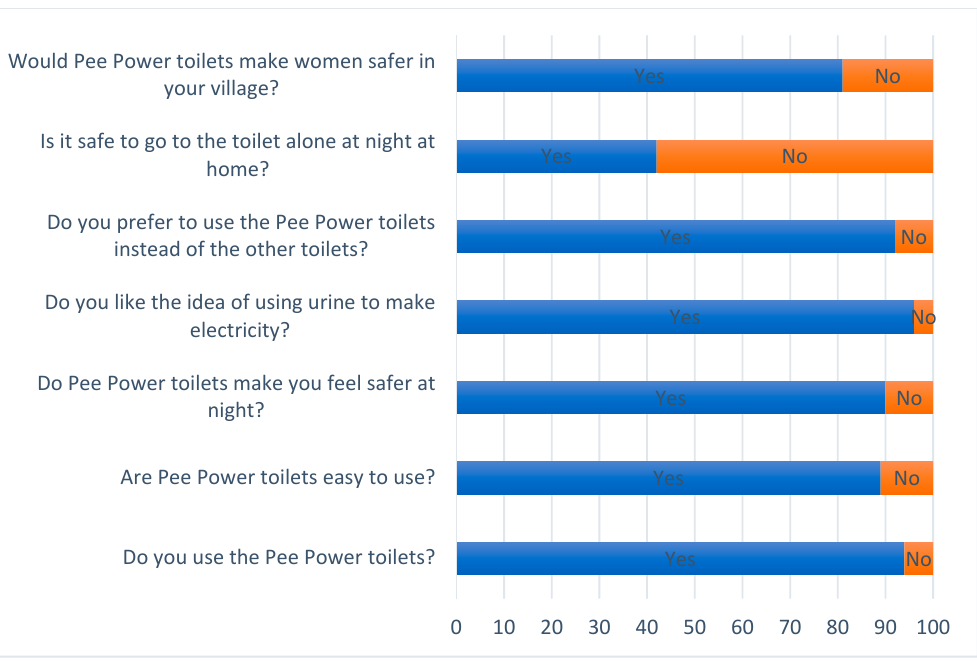
Figure 7. Second post-installation (1 year of operation) questions and answers.